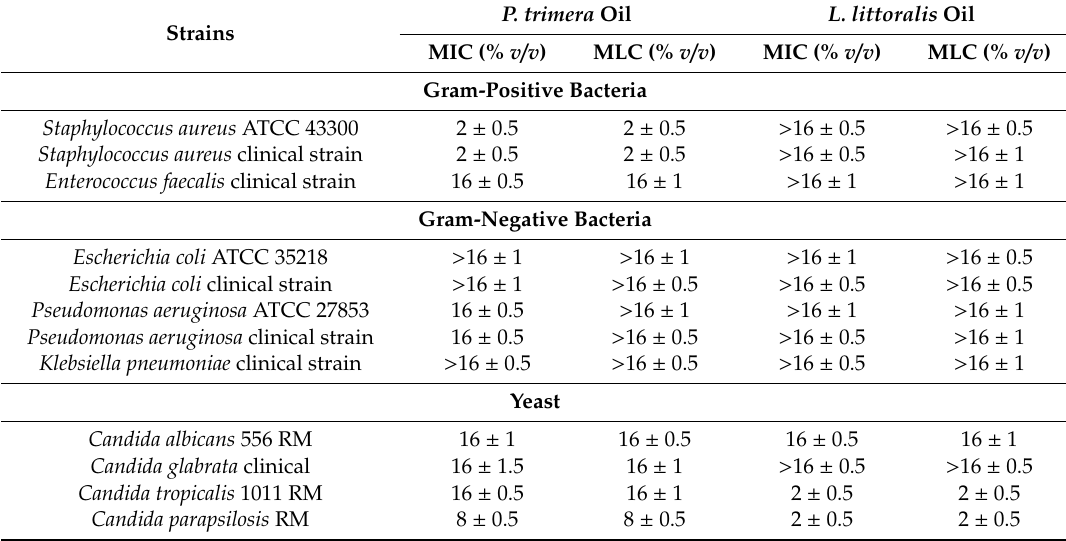
Table 2. Antimicrobial activities (MIC and MLC) of essential oils from the leaves of P. trimera and L.